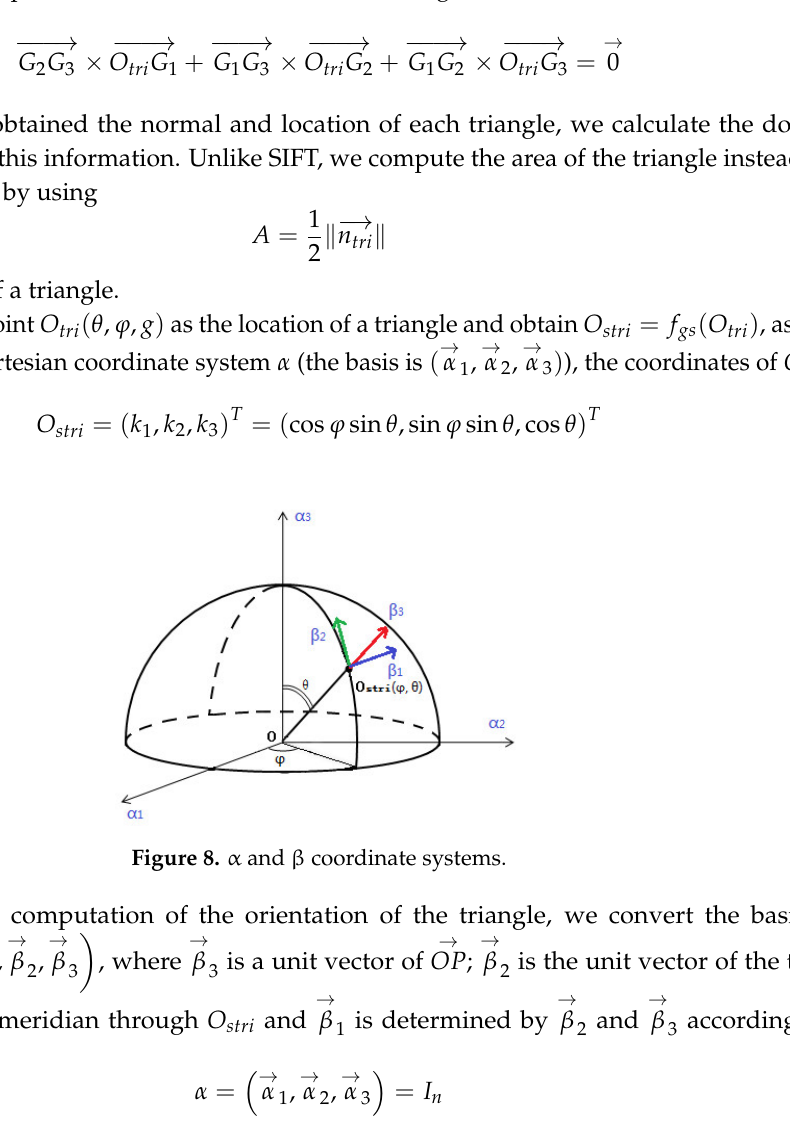
Figure 7. A triangle after triangulation.